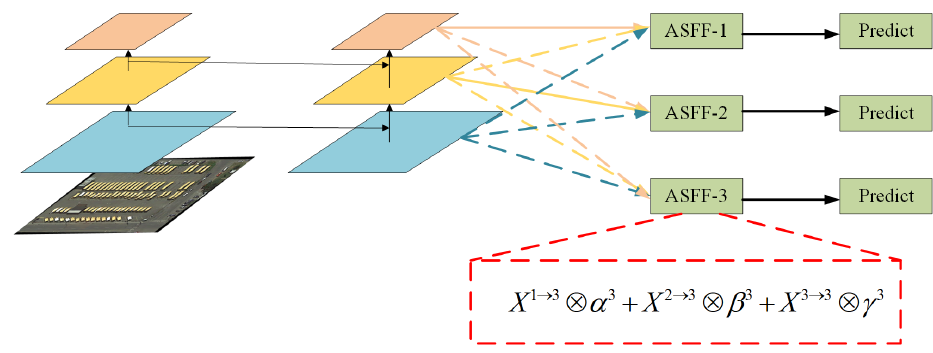
Figure 4. Adaptive feature